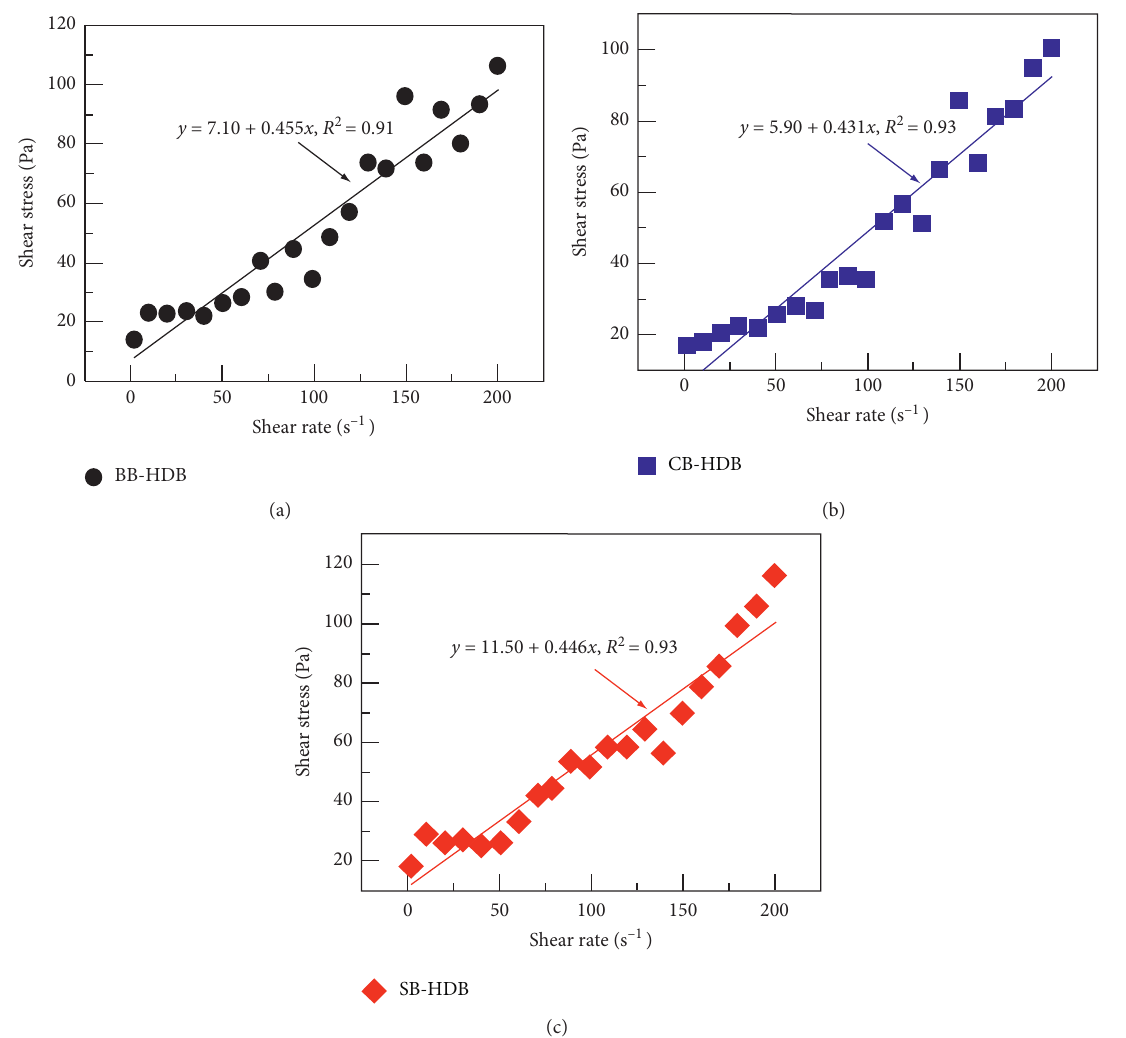
Figure 6: Rheological properties (shear rate vs. shear stress) of (a) BB-HDB, (b) CB-HDB, and (c) SB-HDB.